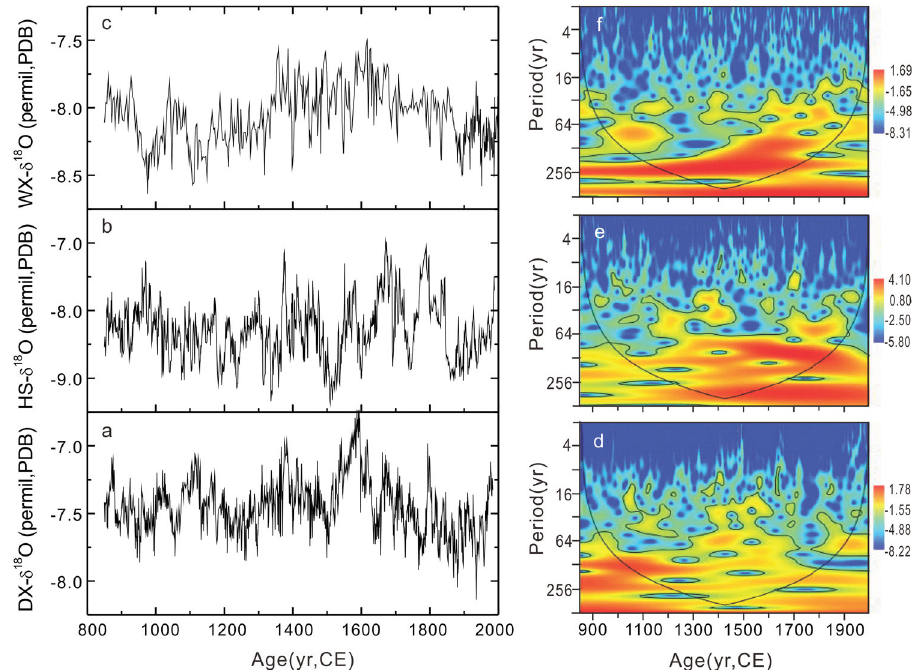
Fig. 4 Comparison of the stalagmite δ 18 O records from DG, HS, and WX cave. The δ 18 O records from DG ( a ), HS ( b ), and WX ( c ), as well as their wavelet analysis ( d – f ) demonstrate their variations on different time scales with different frequencies and amplitudes, indicating that the contributions of the driving forces to the stalagmite δ 18 O are different from site to